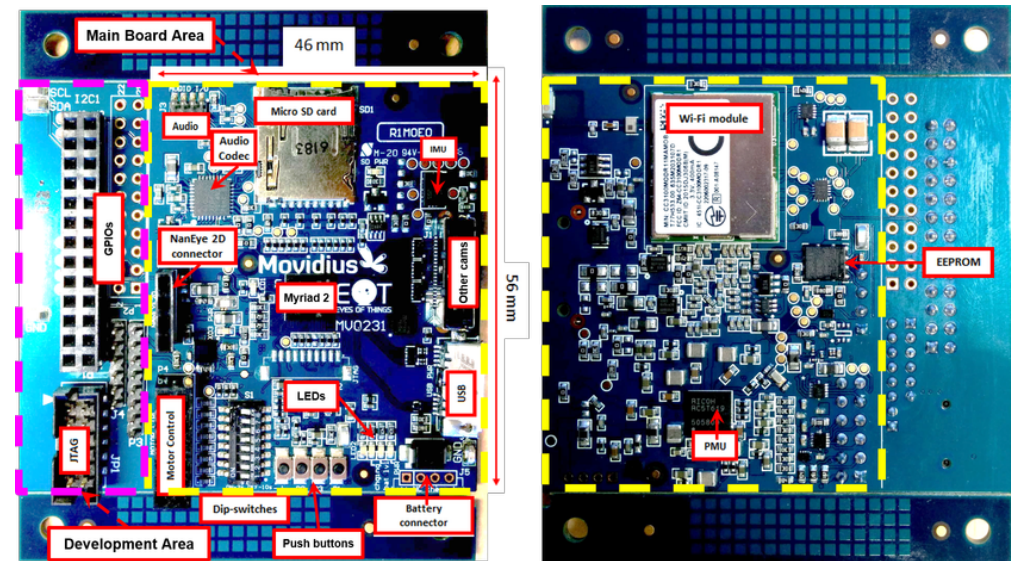
Figure 2. Top and rear views of the EoT board, showing the main components.